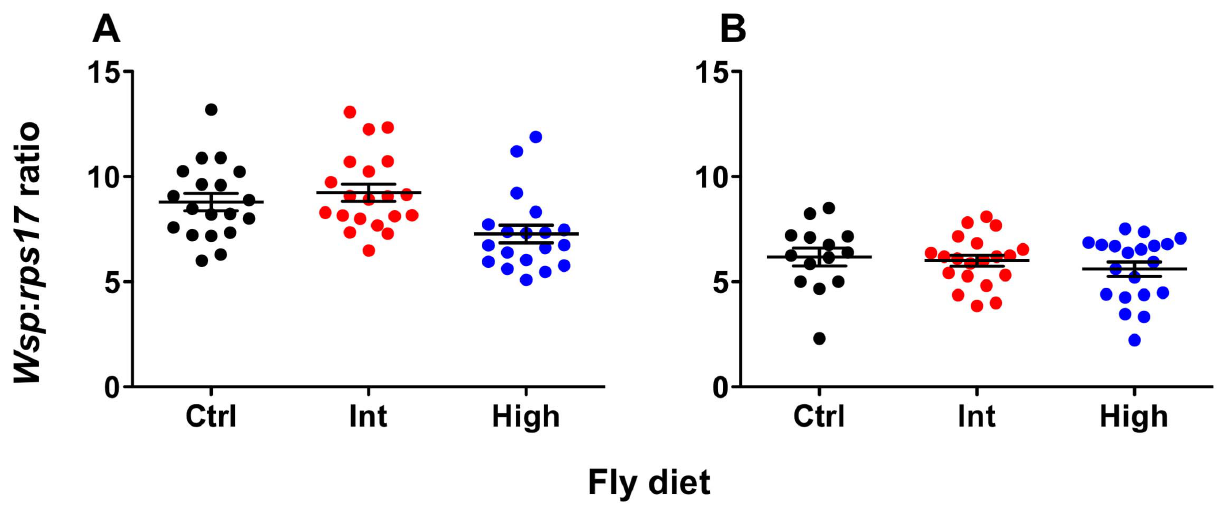
Figure 3. Wolbachia levels of flies reared on cholesterol-enriched food. Mean ( 6 s.e.m.) normalized wsp:rps17 expression ratios for w MelPop- ( A ) and w MelCS-infected flies ( B ) during the age window that survival assays were performed. Flies were collected simultaneously with survival experiment two for w MelPop and survival experiment one for w MelCS. Total Wolbachia levels were quantified using qPCR. Data were compared statistically using ANOVA and student’s t -tests corrected for multiple comparisons. For w MelPop-infected flies, Wolbachia levels were significantly lower after rearing on the High cholesterol diet, than on the Intermediate (Student’s t test: t= 3.370, df=37, P , 0.01) or Standard diets (Student’s t test: t= 2.586, df=36, P , 0.05). Interestingly, this difference in density did not have a corresponding difference in survival was between flies from the two cholesterol-enriched diets. There was no effect of diet on Wolbachia levels in w MelCS-infected flies.